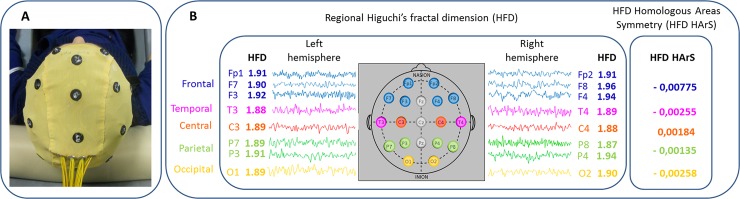
Experimental setup.A) 19-channel EEG cap. B) Regional HFD and HFD Homologous areas symmetry (HArS) estimates (explicative values). HFD is calculated over the whole time series measured at each derivation (windows of 2-seconds are displayed). HFD values are averaged across multiple derivations that overlay the same brain region (frontal and parietal). HArS estimates left vs. right normalized HFD difference (see methods).